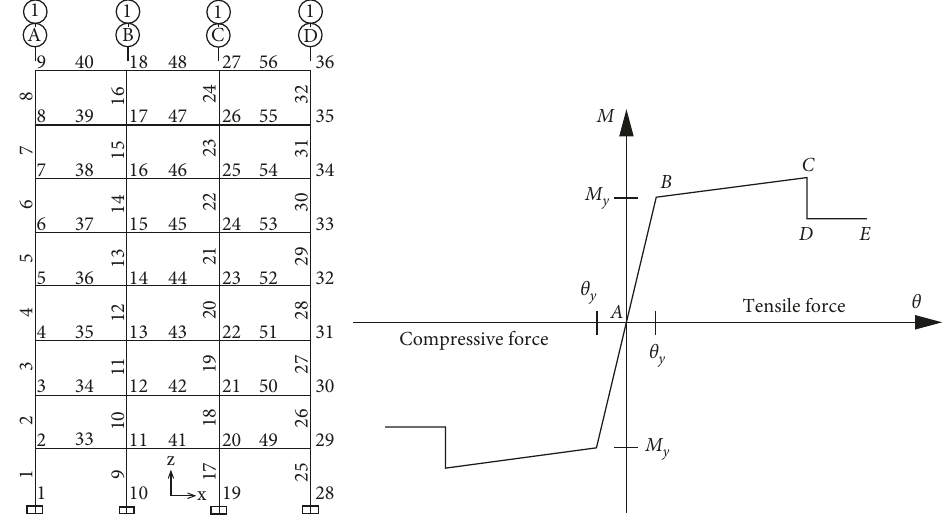
Figure 6: The 8-story steel frame’s finite element planar model.